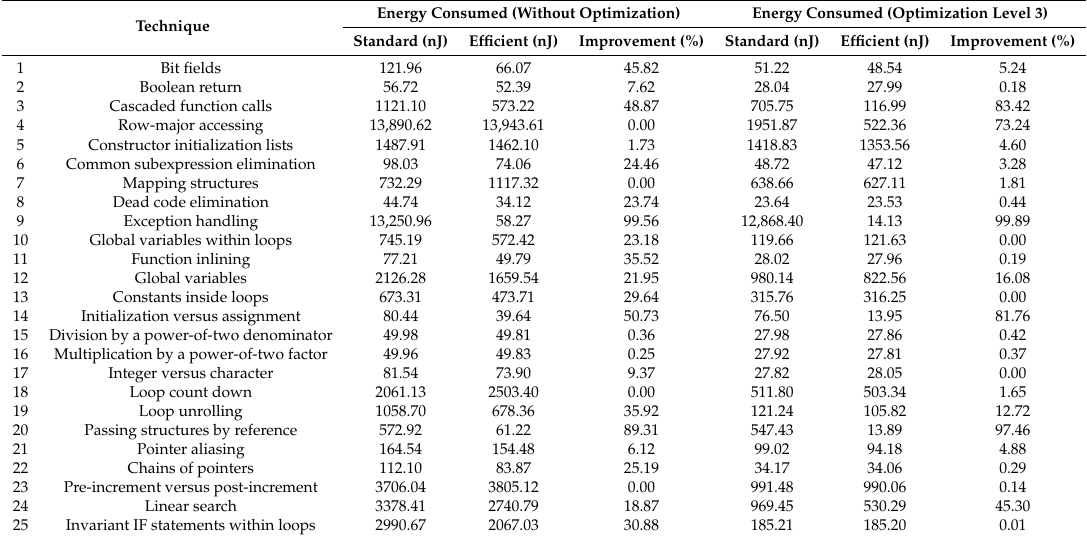
Table 2. Energy results and percentages of improvement in Raspberry Pi 2B.